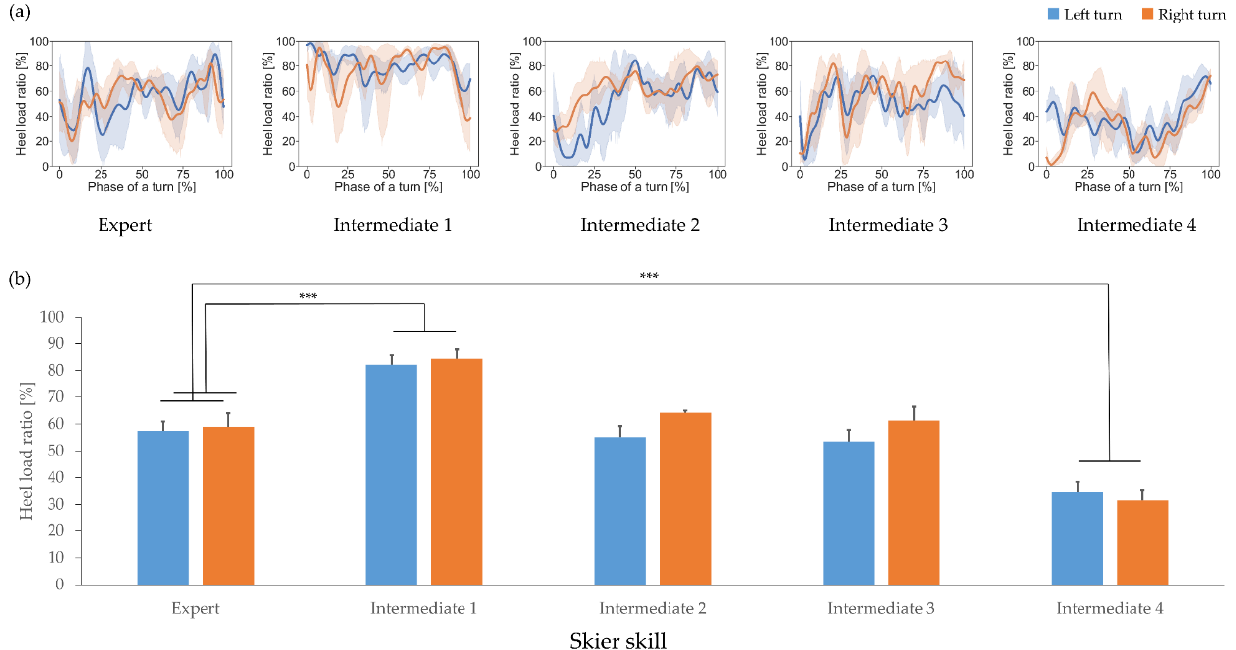
Figure 8. ( a ) Heel load ratio time-series data for each participant and ( b ) the mean heel load ratio. Blue and orange represent the left and right turns, respectively. Statistical significance is indicated with *** p < 0.001. Table 3. Results of the post-hoc comparisons for mean heel load ratio. The expert skier was com- pared to each intermediate skier.